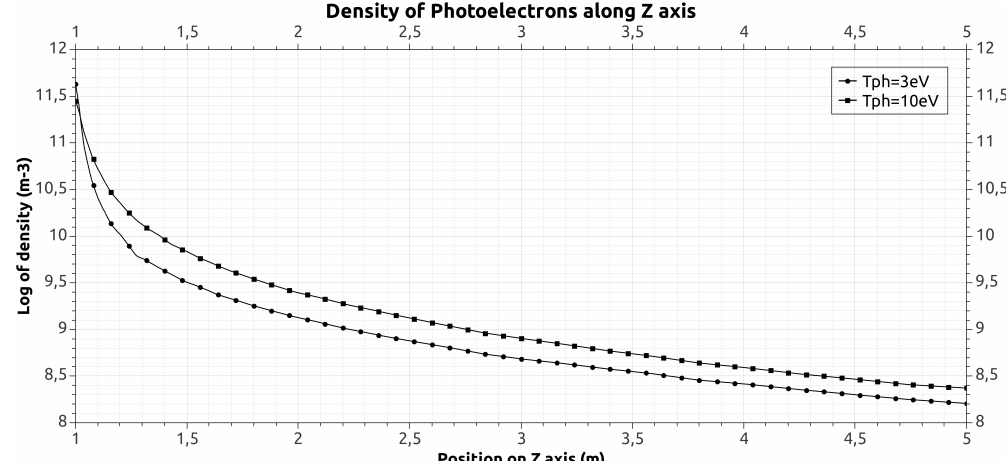
Fig. 9. Cross comparison simulation B (SPIS): plot along the z-axis of the photoelectron density, from the center of the heatshield to the upper boundary of the simulation box. The circled line represents the density for a photoelectron emission temperature of 3eV, the squared line is for a temperature of 10eV.